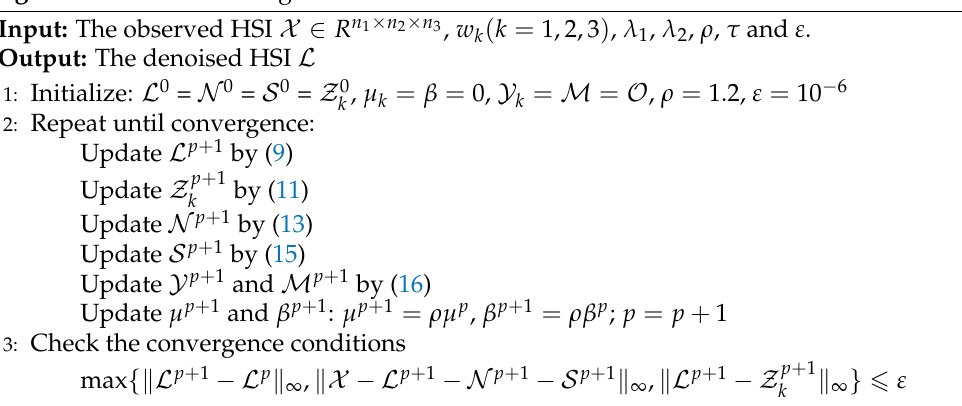
Algorithm 2 HSI Denoising via the F-3MTNN